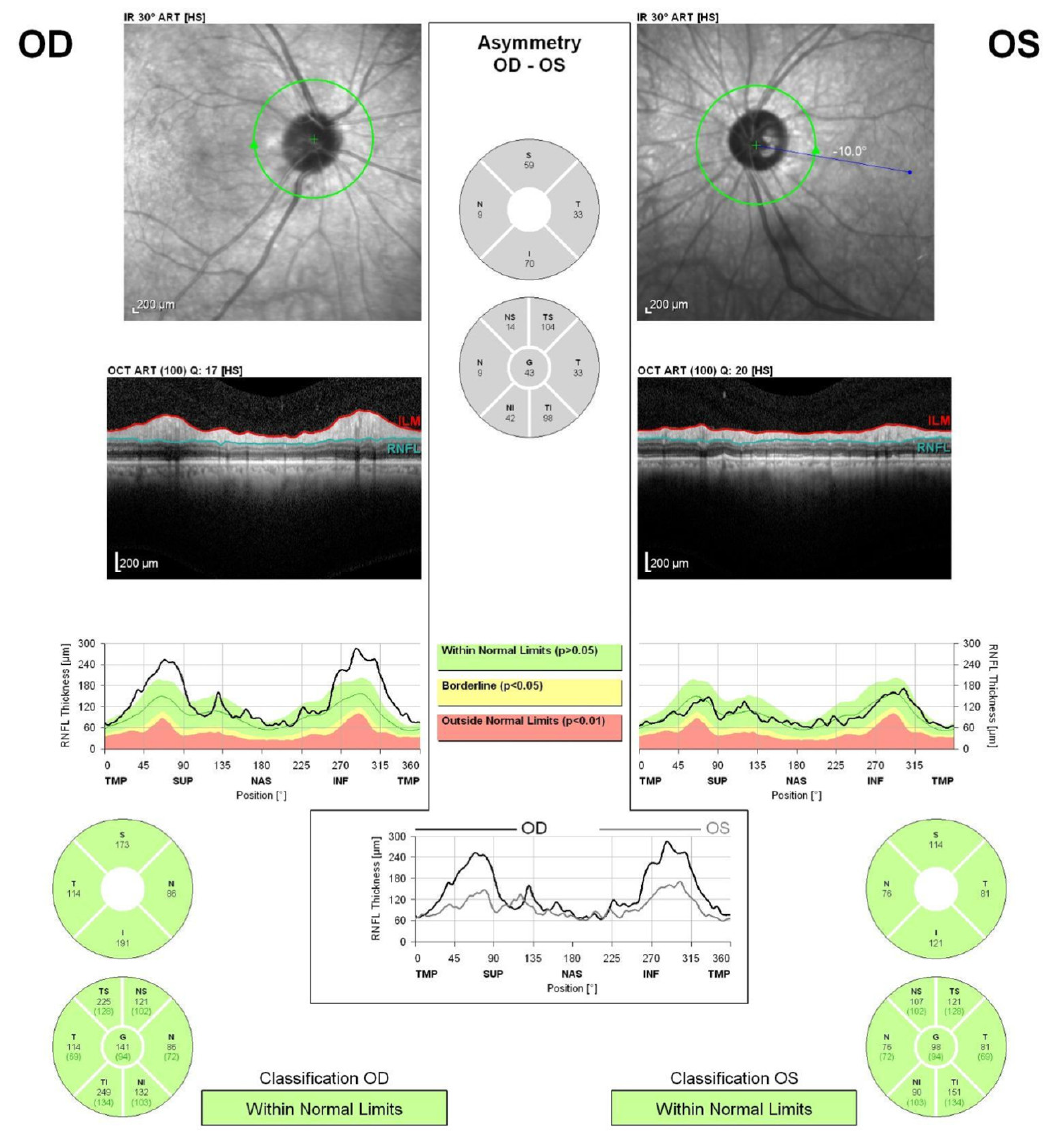
Figure 2. Retinal nerve fiber layer thickness around the optic nerve head of the right eye ( OD ) and left eye ( OS ) measured by spectral domain optical coherence tomography.